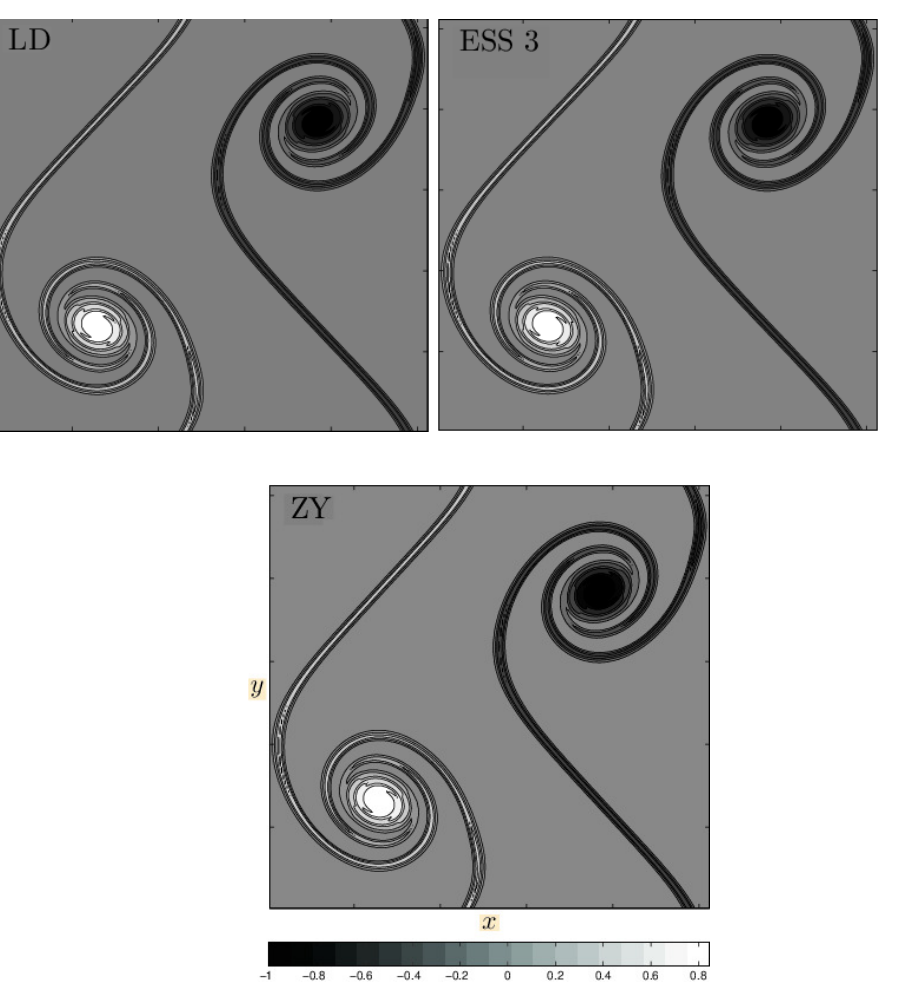
Figure 6. Double shear layer. The grid resolution is 256 × 256, Ma = 0.0693, Re = 3 × 10 4 . The normalized vorticity plots are presented at the moment of time t = t c ; LD is the low-dissipative entropic method described in Proposition 1; EELB 3 is the third-order EELB method; ZY is the method of Zhao and Yong.